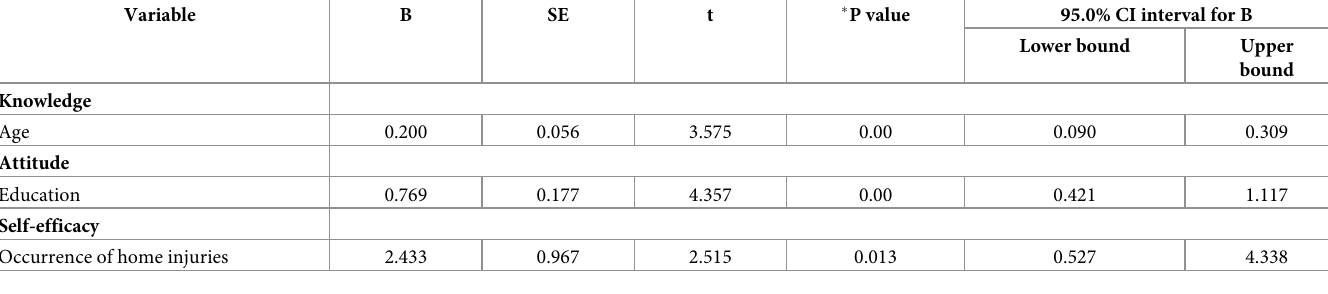
Table 4. Regression analyses of factors significantly predict post-intervention total knowledge, attitude, and self-efficacy for mothers about home injuries. Variable B SE t (cid:3) P value 95.0% CI interval for B